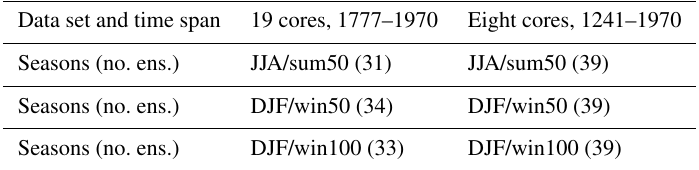
Figure 1. (a–c) Loadings of the first three PCs of ice core δ 18 O for winter using 19 cores. Panels (d) – (f) are the same as (a) – (c) but for modeled precipitation weighted δ 18 O for November–April at the sites of the 19 ice cores. Results for summer and annual data are very similar (not shown). In (d) – (f) the crosses mark the model grid showing the horizontal model resolution of 3 . 75 ◦ × 3 . 75 ◦ . Table 2. Reconstructions featured in this study. A total of 12 reconstructions are done using six data sets – e.g., both the reconstructions for JJA (summer) and sum50 use the same ice core data representing the summer season May–October but targeting the differently defined summer seasons by extracting either JJA or May–October from the model output. The number of ensemble members (no. ens.) are given in parenthesis for each set of seasons. The winter reconstruction for DJF (winter) using eight ice cores covering 1241–1970 is published in Sjolte et al.